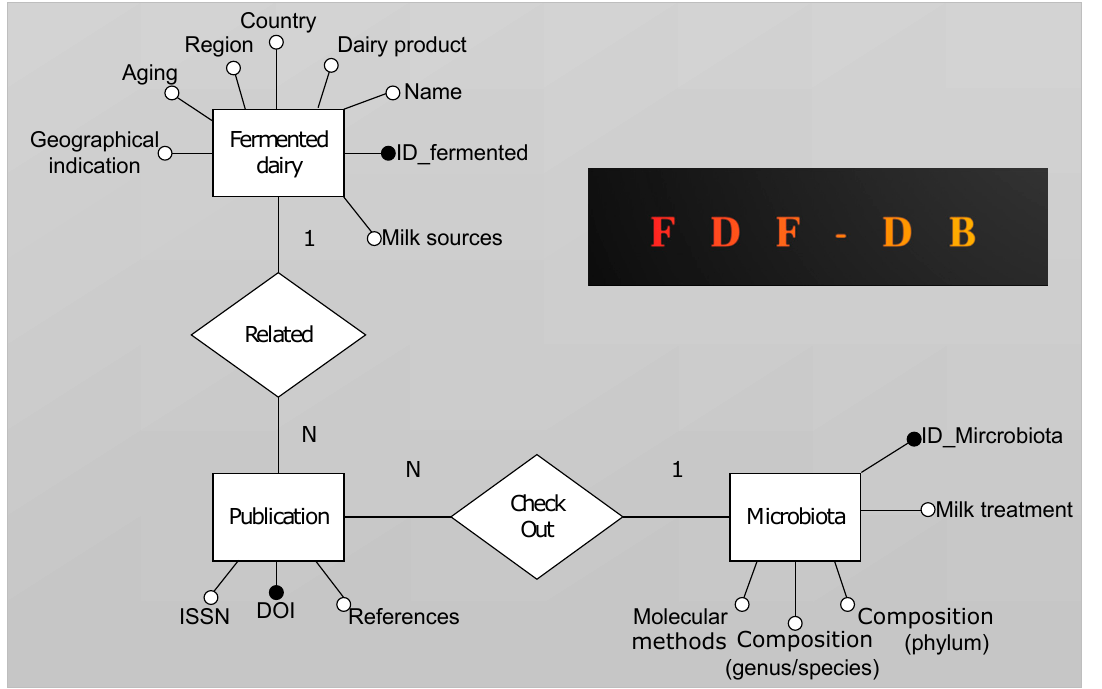
Figure 1. Entity relationship diagram of Fermented diary database. The diagram represents relation- ships among the stored